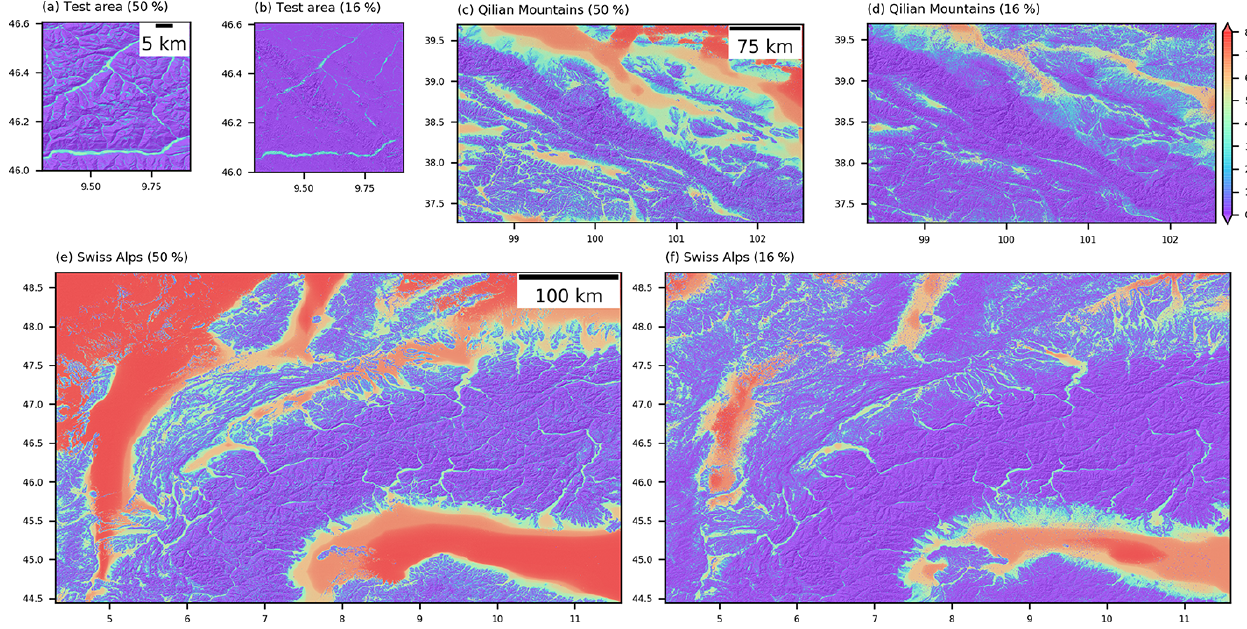
Figure B3. Original MRVBF in the test area, Swiss Alps and the Qilian Mountains by using a slope threshold of 50 and